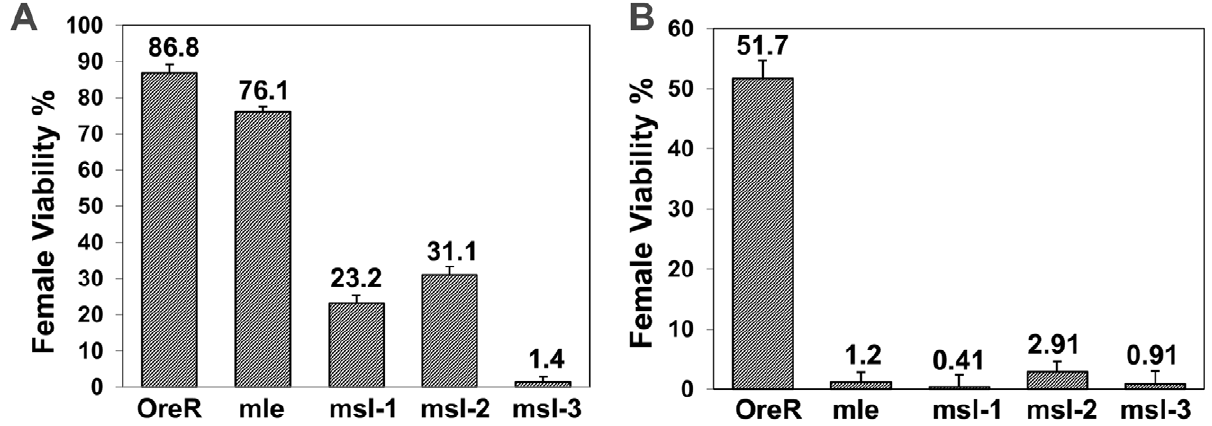
Figure 1. Removal of maternal msls reduces female viability when female determining gene dose is compromised. Genotype of mothers shown on x-axis; percent female viability relative to their brothers is shown with percentage standard error. (A) Ore R or homozygous mle 1 , msl-1 L60 , msl-2 1 or msl-3 1 females mated to y, w, cm, Sxl fP7B0 /Y (test classes total n=439, 1088, 522, 489, 1065, respectively). Females homozygous for the Sxl fP7B0 deficiency are lethal but males with the deficiency are viable. (B) Ore R or homozygous mle 1 , msl-1 L60 , msl-2 1 or msl-3 1 females mated to w, sis-b sc3-1 , sis-a 1 , m /Y (test classes total n=270, 934, 593, 849, 555, respectively).